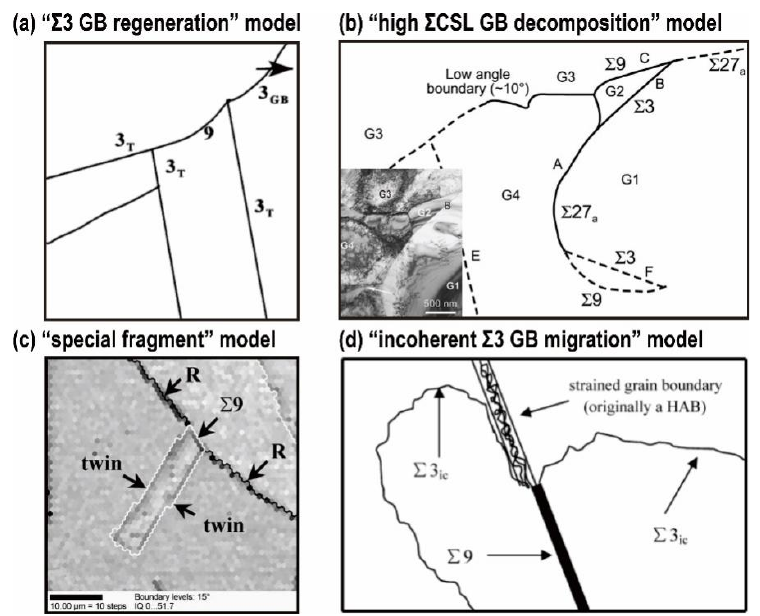
Figure 1. Theoretical models for the GBCD optimization in FCC metals Adopted from Refs. [17,56–